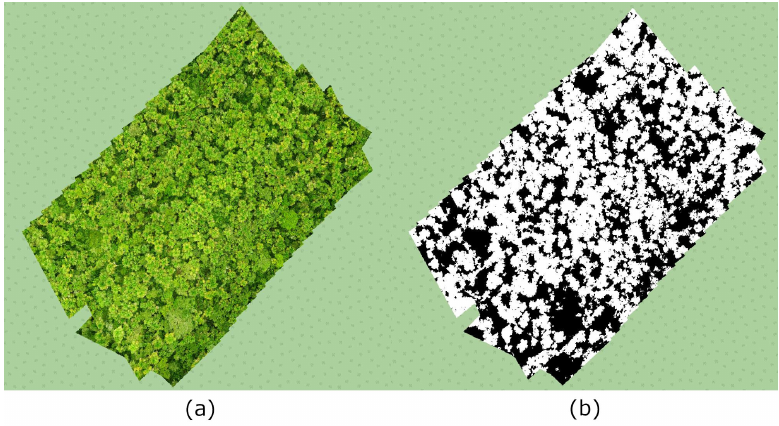
Figure 12. Aerial image mosaic composed of 168 photographs. ( a ) Mosaic of RGB images. ( b ) Mosaic of Mauritia flexuosa